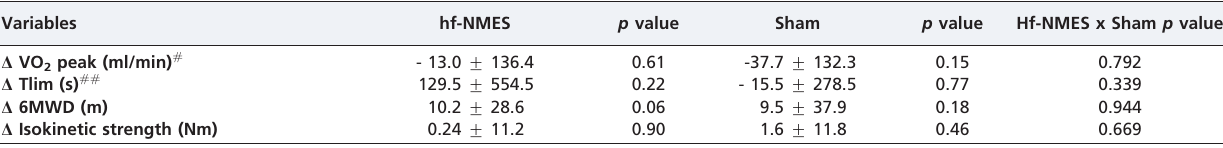
Muscle electrical stimulation in COPD patients Napolis LM et Table 2 - Changes ( D ) in exercise capacity and muscle strength in COPD patients after hf-NMES and sham stimulation. Variables hf-NMES